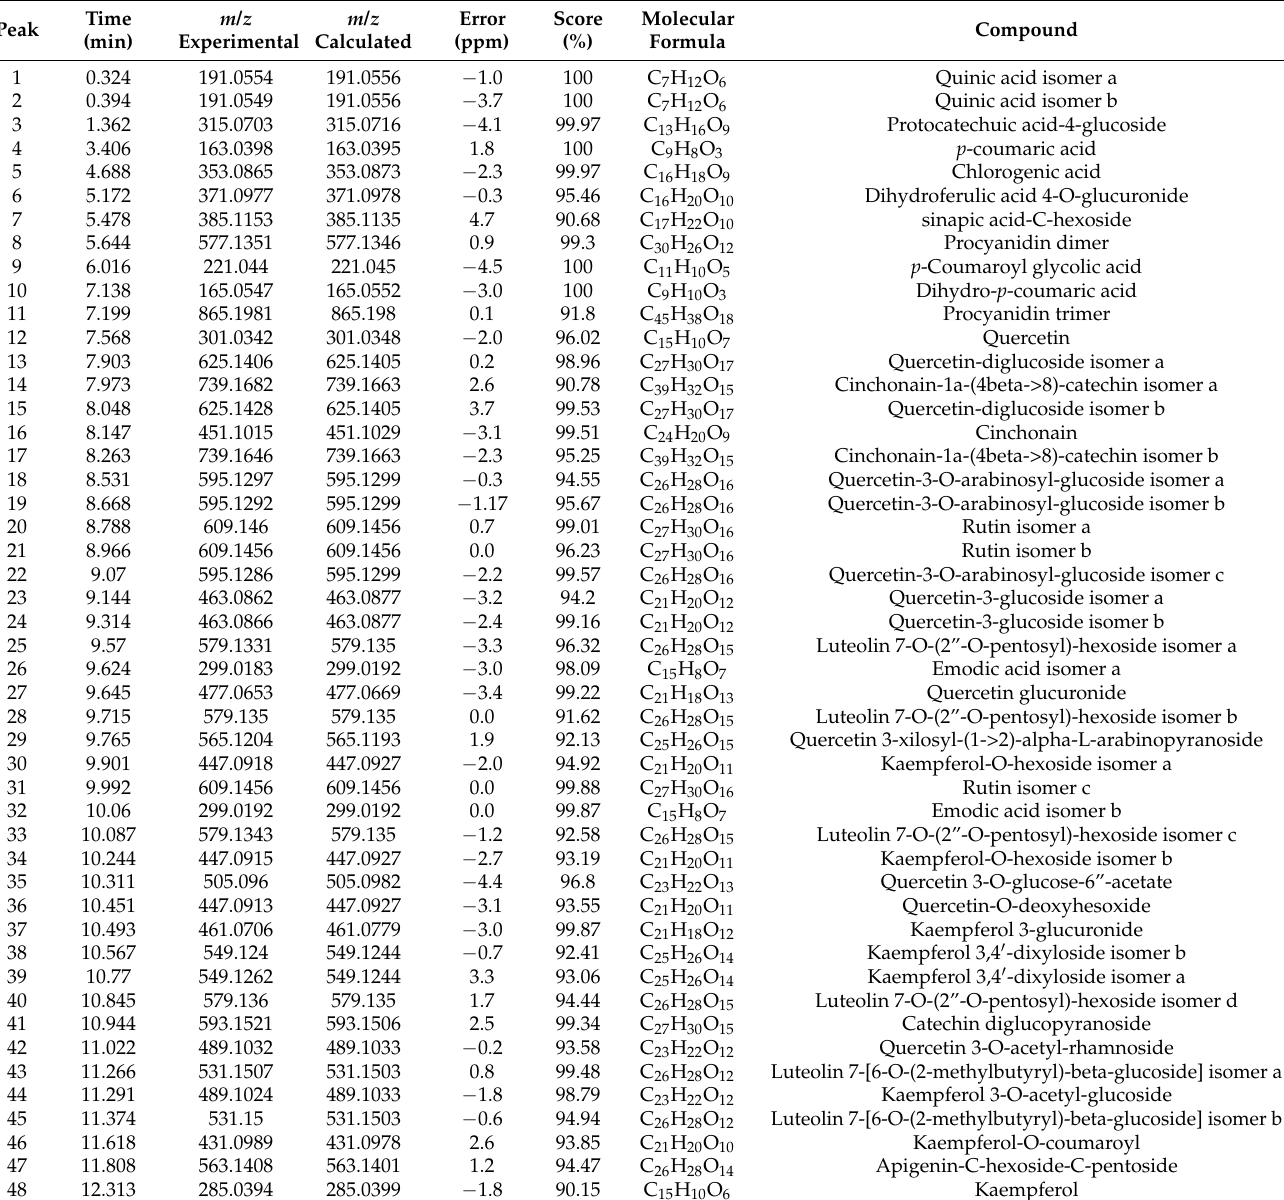
Table 2. Identified compounds in fermented and non-fermented avocado leaf by